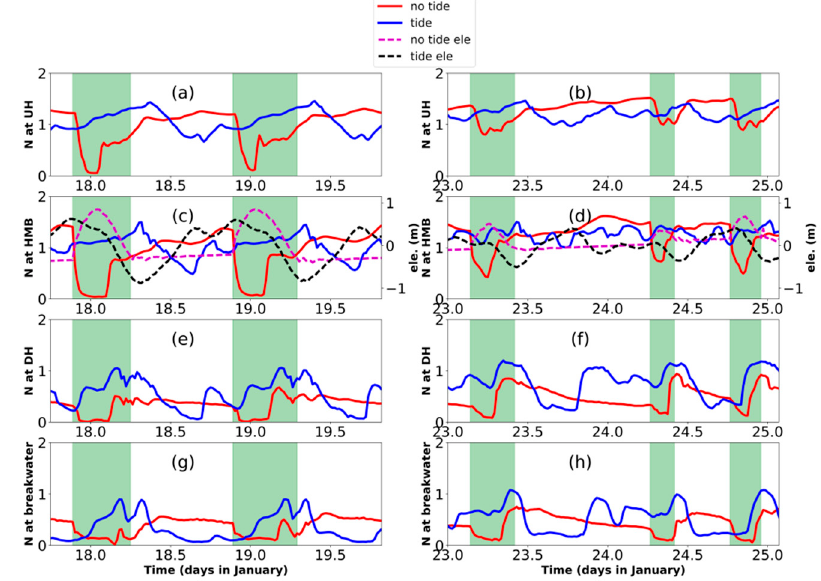
Figure 8. Time series of stratification index N (calculated by Equation (2)) in 4 cross-sections: UH ( a , b ); HMB ( c , d ); DH ( e , f ) and breakwater ( g , h ). Spring (17.75th–19.92th of January) and neap phases (23rd–25.07th of January), which contain 2 semi-diurnal cycles, were plotted on the left panels and right panels. Values in the tide-receiving scenario were plotted in blue curves and in the non-tide-receiving scenario in red curves, with the tide gate opening period marked out by green shadows. Tidal elevations of HMB were plotted to show the tidal phases ( c , d ).